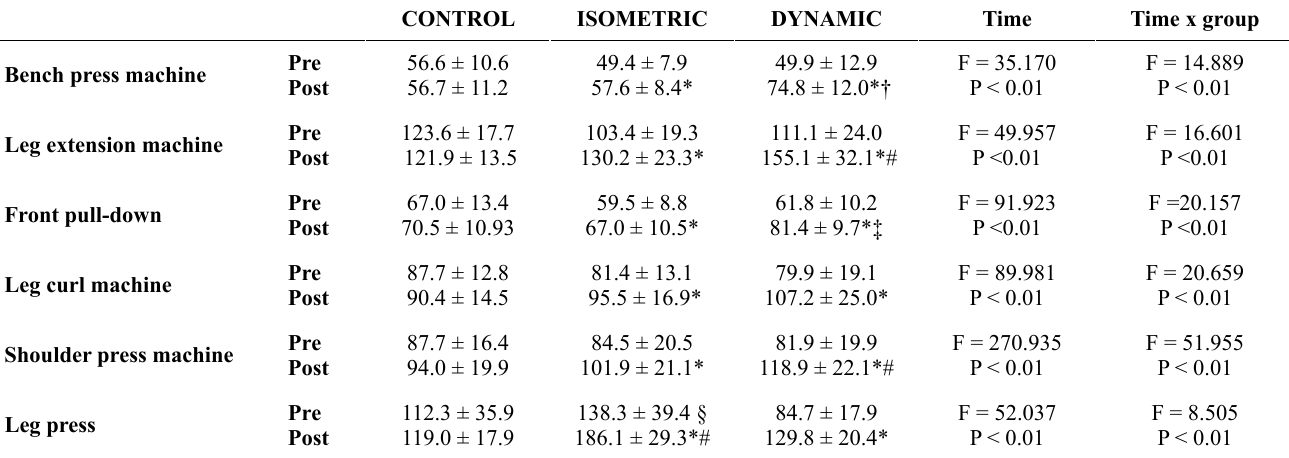
Table 3. Mean (±SD) of strength (kg) obtained through a dynamic one-repetition maximum test, in each exercise, in the different interventions. CONTROL ISOMETRIC DYNAMIC